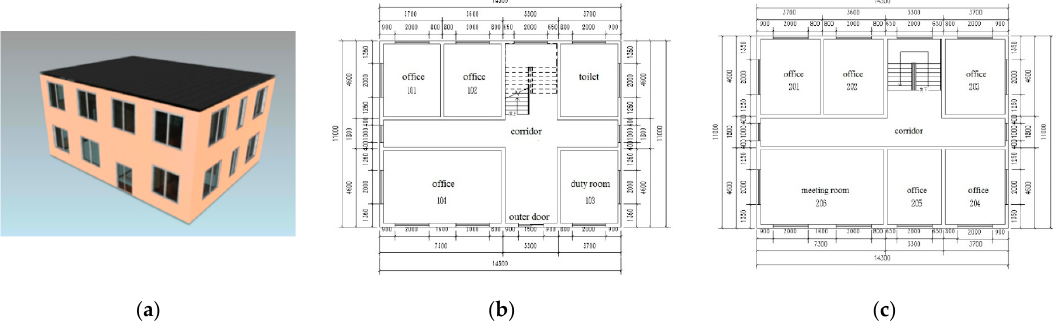
Figure 1. Outward appearance effect and floor plans of the construction. ( a ) The construction’s outward appearance effect chart; ( b ) first floor plan; ( c ) second floor plan.